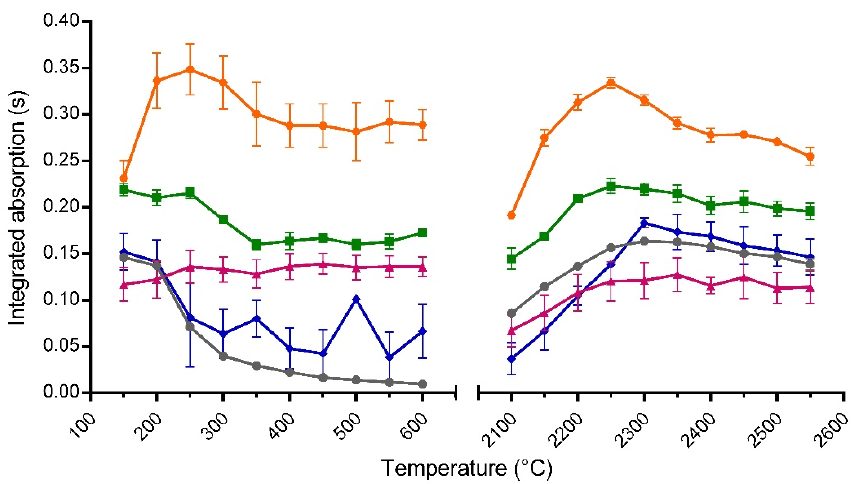
Figure 3. Pyrolysis ( left ) and vaporization ( right ) curves for measuring sulfur based on the absorp- tion of CS. A volume of 10 μ L of an aqueous solution of GSH (50 μ g mL − 1 ) was used. Zirconium coating ( ) of the graphite tube was employed as permanent modifier and additionally 10 μ L of calcium 1 g L − 1 ( ), 10 μ L of magnesium 1 g L − 1 ( ), 10 μ L of palladium 10 g L − 1 ( ), or 2 μ L of calcium 1 g L − 1 and 10 μ L of palladium 10 g L − 1 ( ) as chemical modifiers besides zirconium coating. The data represent mean ± standard error of 3 replications (merely 2 conductions for zirconium only) with each 3 injections.